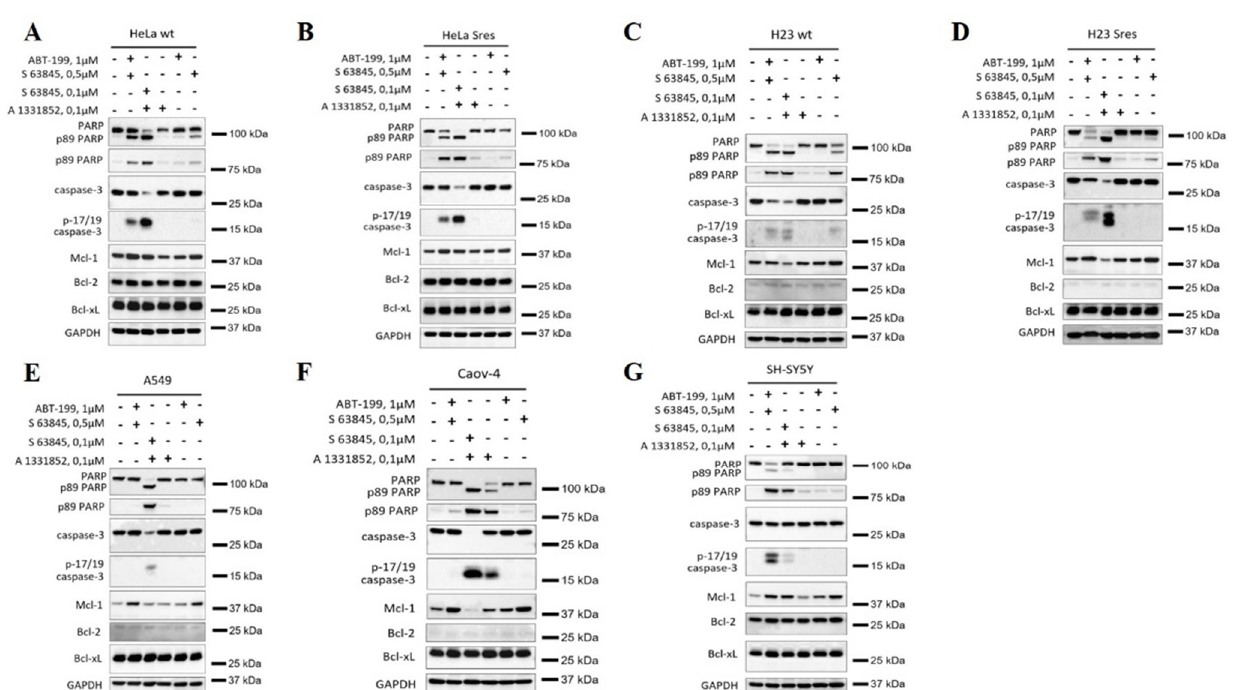
Figure 5. Analysis of the efficiency of combination of S63845 with BH3 mimetics to Bcl-2 (ABT-199, venetoclax) or Bcl-xL (A1331852). WB analysis of Hela ( A ), HeLa S res ( B ), H23 ( C ), H23 S res ( D ), A549 ( E ), Caov-4 ( F ), and SH-SY5Y ( G ) cell lines treated with S63845, venetoclax (ABT-199) or A1331852 at stated concentrations. Data from n = 3 biological replicates. GAPDH was used as a loading control. Time of incubation: 6 h.